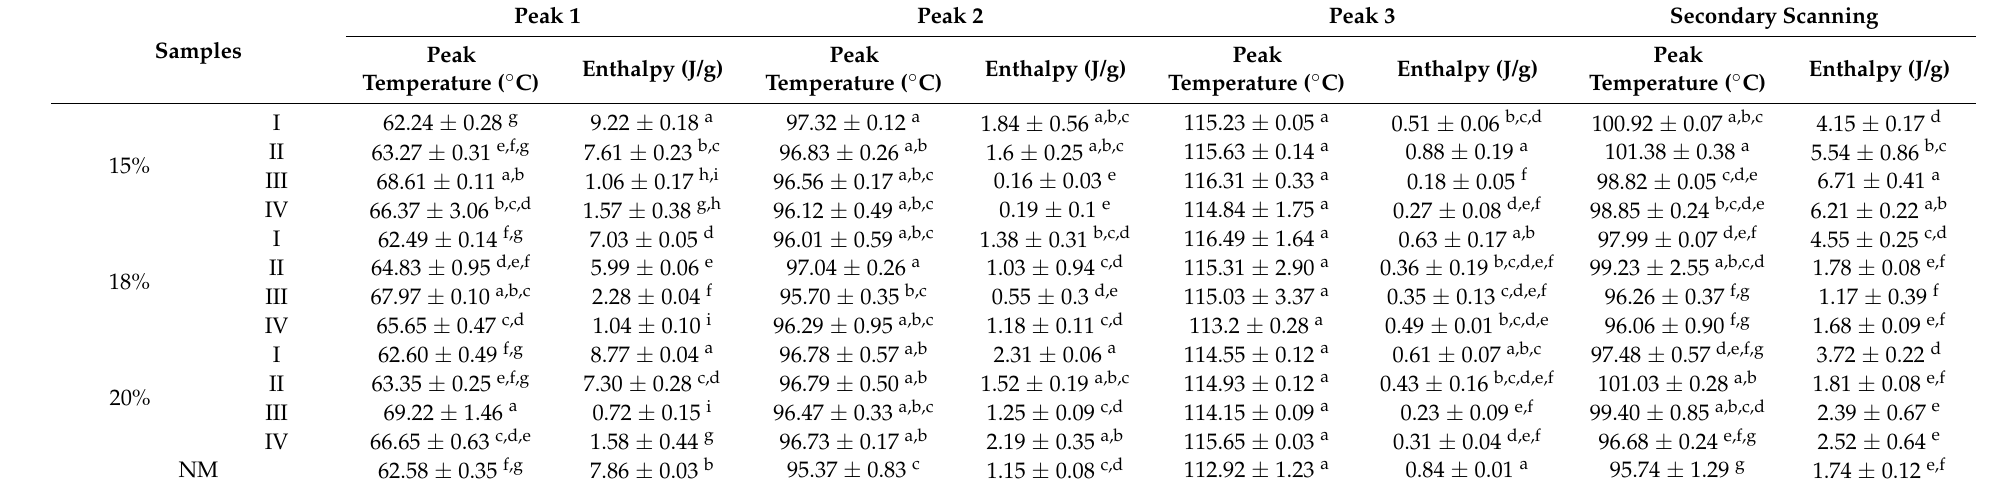
Table 4. DSC peak temperatures and enthalpies for oats in four extrusion zones and raw